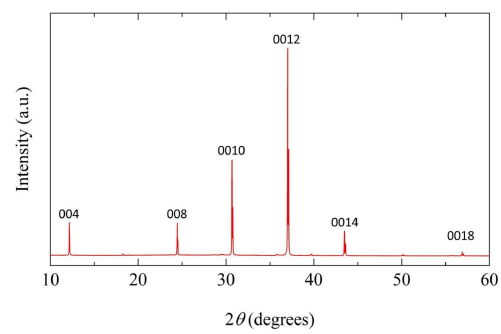
Figure 6. Powder XRD pattern of crushed Bi 4 NbO 8 Br single crystals, showing a strong orientation to the c